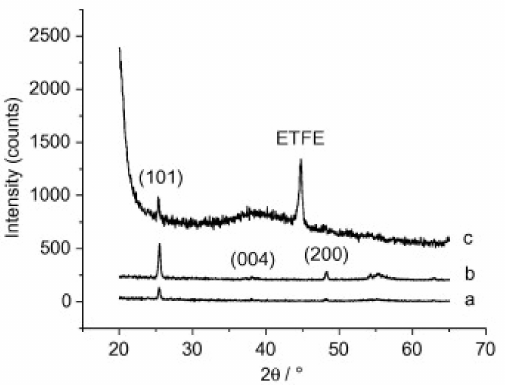
Figure 15. XRD patterns of anatase TiO 2 films in substrates made of ( a ) Si at 200 ◦ C, ( b ) PMMA at 250 ◦ C, and ( c ) ETFE ate 200 ◦ C. Si substrate was used as a reference, for comparison purpose (reprinted from [66] Copyright (2008), with permission from Elsevier).